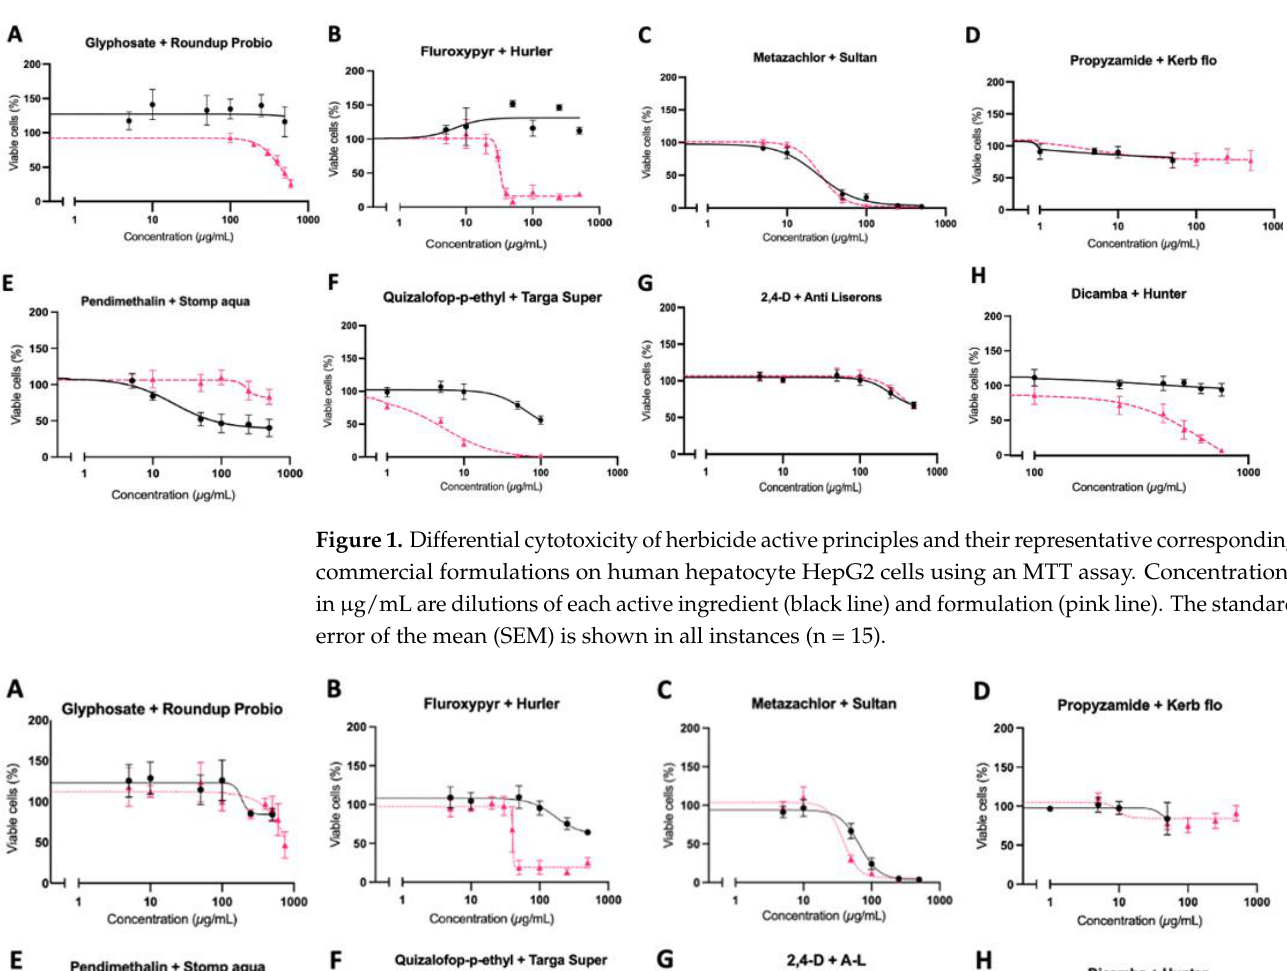
Figure 3. Measurement of membrane disruption cytotoxicity of herbicide active principles (grey columns) and their representative commercial formulations (pink columns) in human hepatocyte HepG2 cells. Untreated negative control cultures (NC), positive control cultures (PC) treated with 0.05% Triton X100 compared to each active ingredient (grey columns) and its respective commercial formulation (pink columns) 24 h after exposure. Adenylate kinase activity is expressed in relative units (RLU). Standard deviation (SD) is shown in all instances ( 𝑛 = 9). ** p < 0.001, **** p < 0.0001, in a Man-Whitney test which followed a one-way ANOVA.